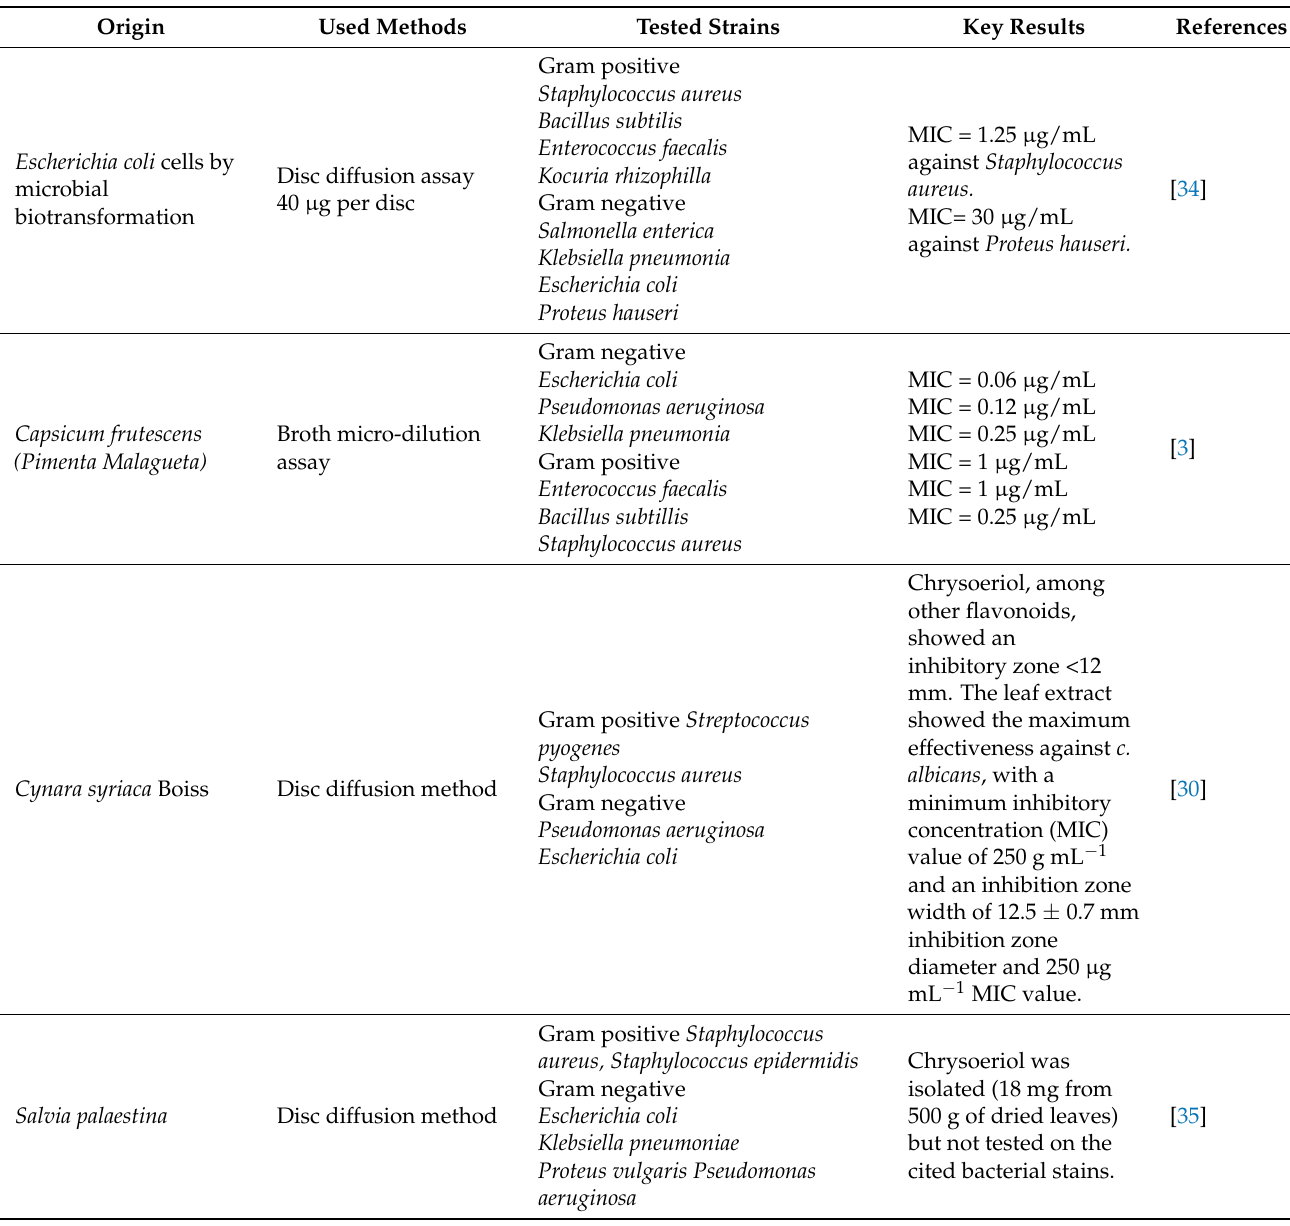
Table 6. Antibacterial activities of